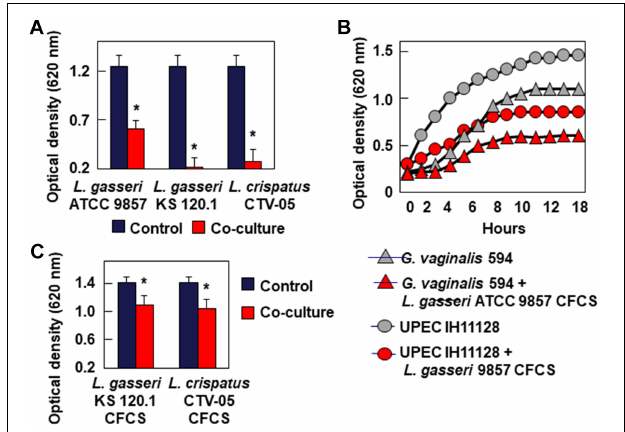
FIGURE 3 | Inhibition of growth of BV-associated G. vaginalis 594, and recurrent cystitis- and preterm labor-associated E. coli strain